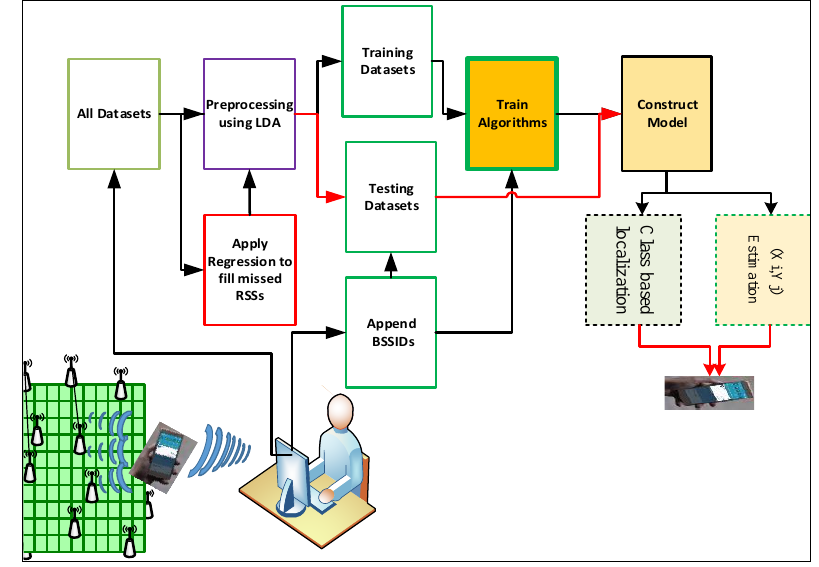
Figure 3. Proposed system structure.